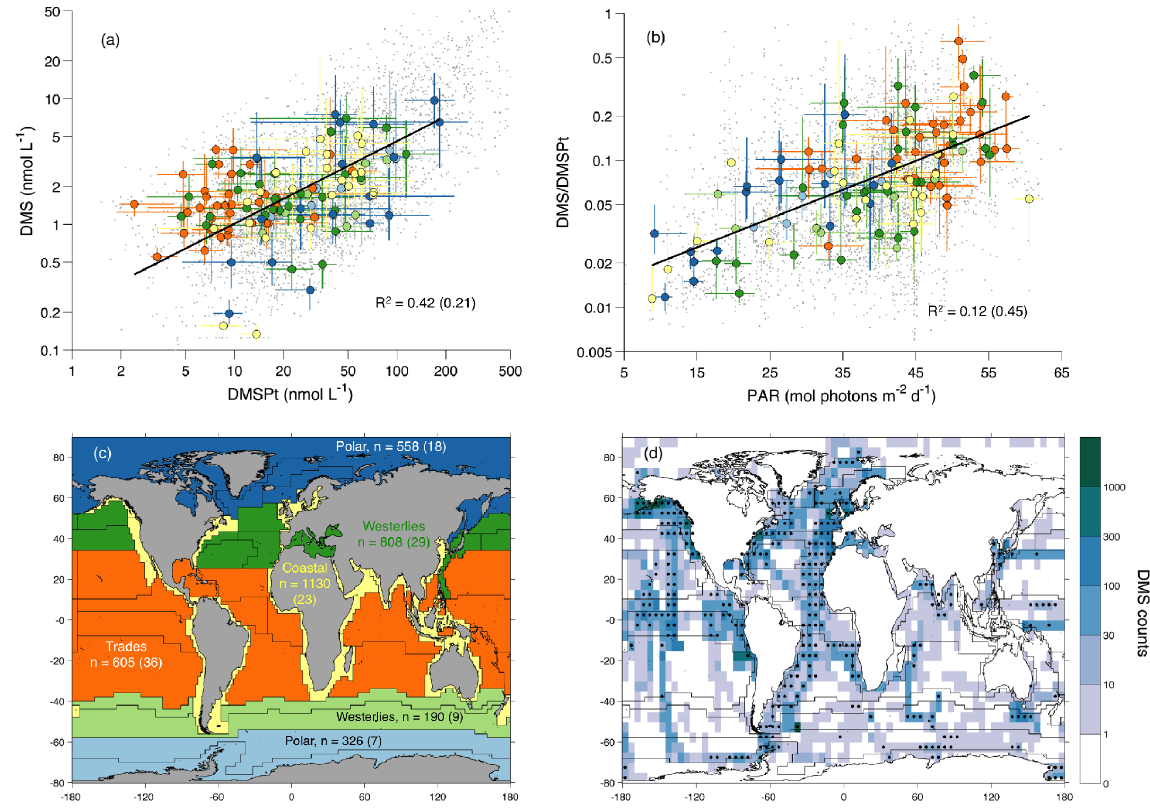
Figure 1. Relationship between DMS, DMSPt and PAR across oceanic biomes and data availability. (a) DMS vs. DMSPt. (b) DMS / DMSPt ratio vs. mean daily irradiance (PAR) at the sea surface. (c) Longhurst biogeochemical provinces and biomes. (d) In situ DMS data counts in 5 ◦ × 5 ◦ latitude–longitude bins; stippling indicates bins with measurements available for 3 or more months. In (a, b) small grey dots represent individual data points and large colored dots represent the median in a given Longhurst biogeochemical province and month and the corresponding interquartile ranges. Province–month medians are colored by biome following the map in (c) , which also shows the amount of DMS–DMSPt–PAR measurements available in each biome. In (a–c) , the R 2 and n (data counts) outside and inside parentheses correspond to non-binned data and province–month (MLongh) binned data, respectively. Regression lines in (a, b) , calculated with MLongh binned data, are only